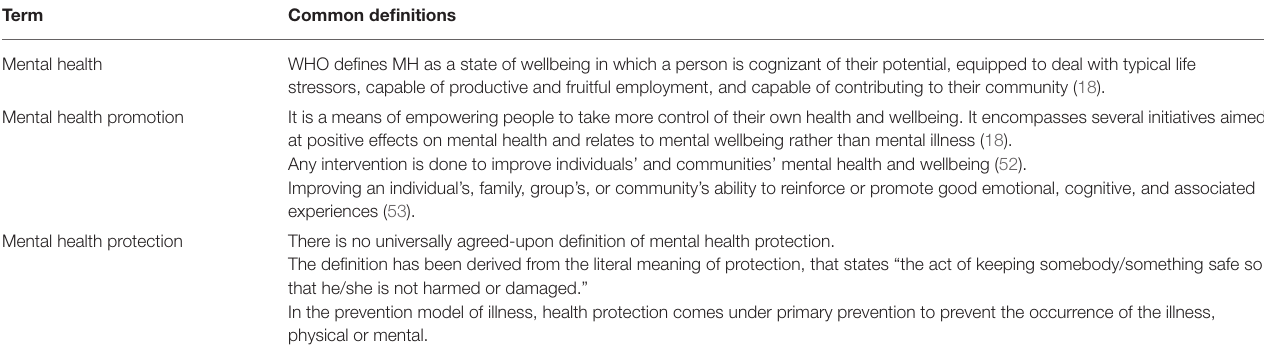
TABLE 1 | Commonly used terms in mental health prevention.